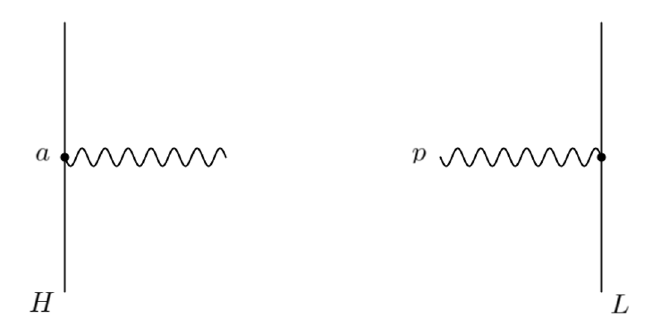
Figure 2 . Vertices denoting the coupling of an exchanged current with the external states O H and O L , respectively.